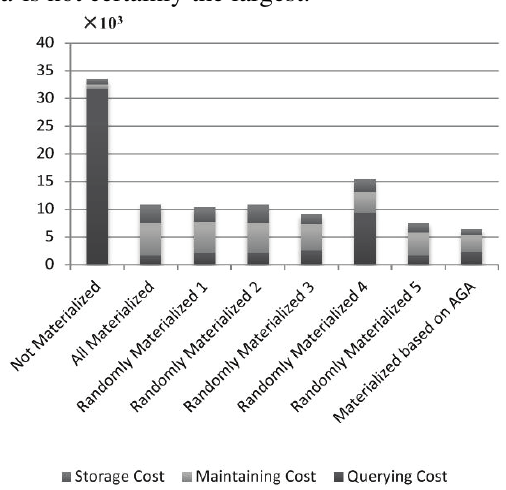
Fig. 7. The cost of different materialization methods with Apache Hive using full lattice model